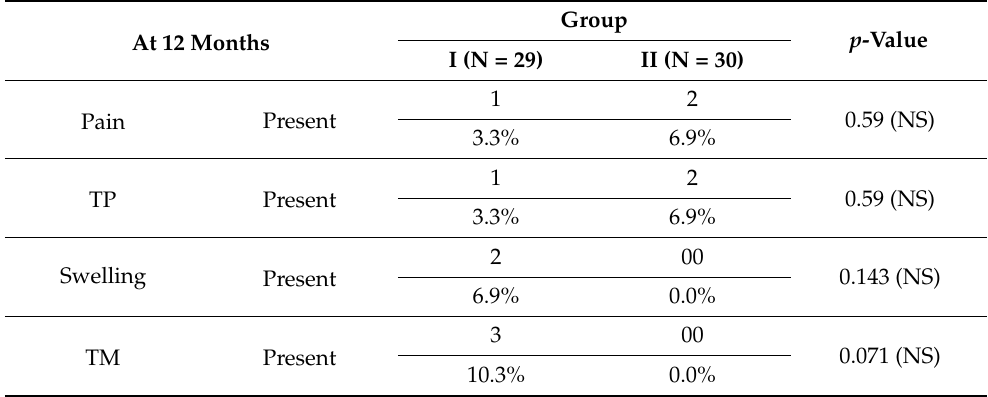
Table 6. Statistical evaluation of the clinical success of pulpotomy at 12 months.